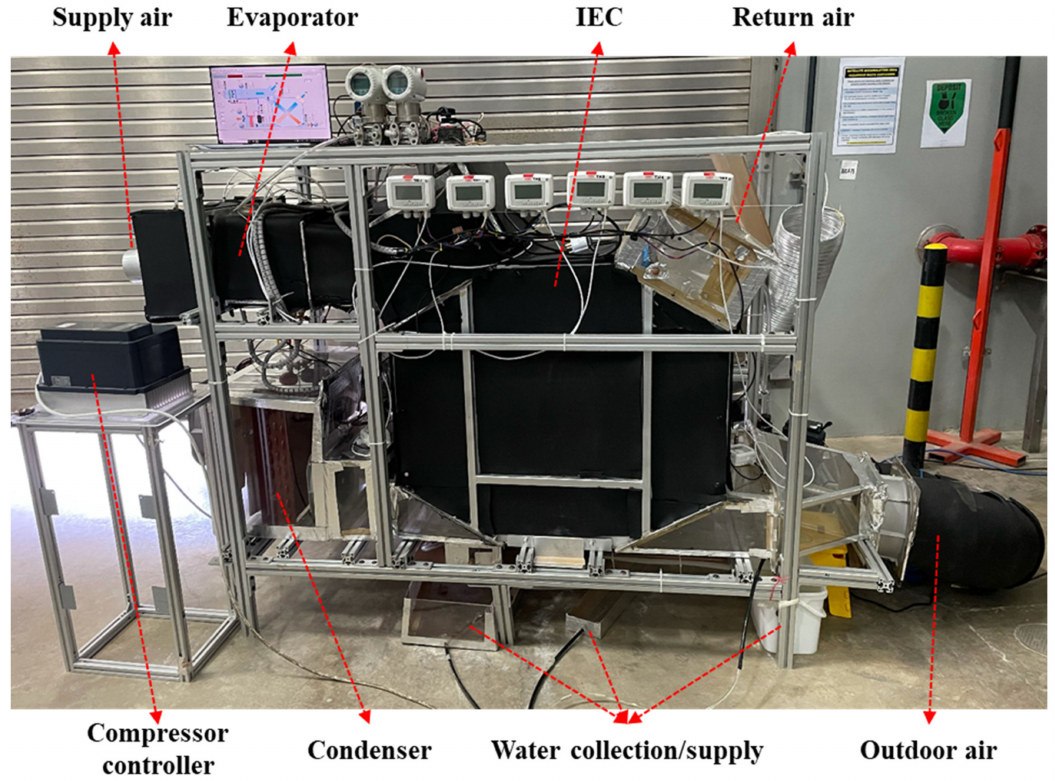
Figure 8. Pilot IEC-MVC unit at KAUST. Reprinted with permission from Ref. [54]. Copyright 2022,